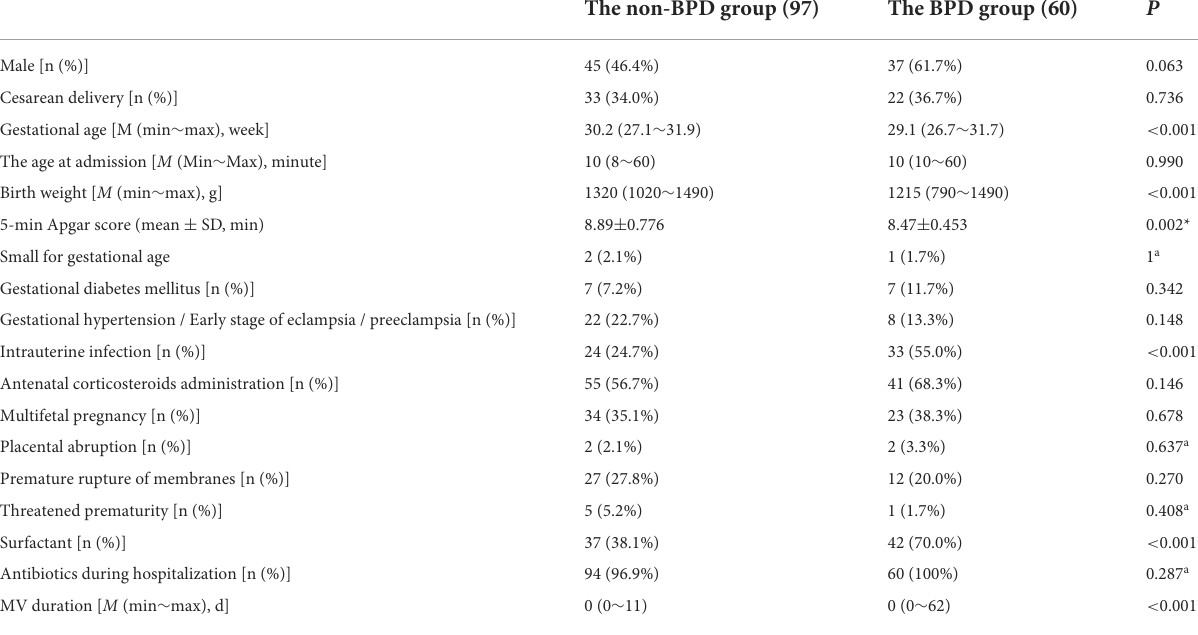
TABLE 1 Comparison of the general characteristics between the non-BPD group and the BPD group in